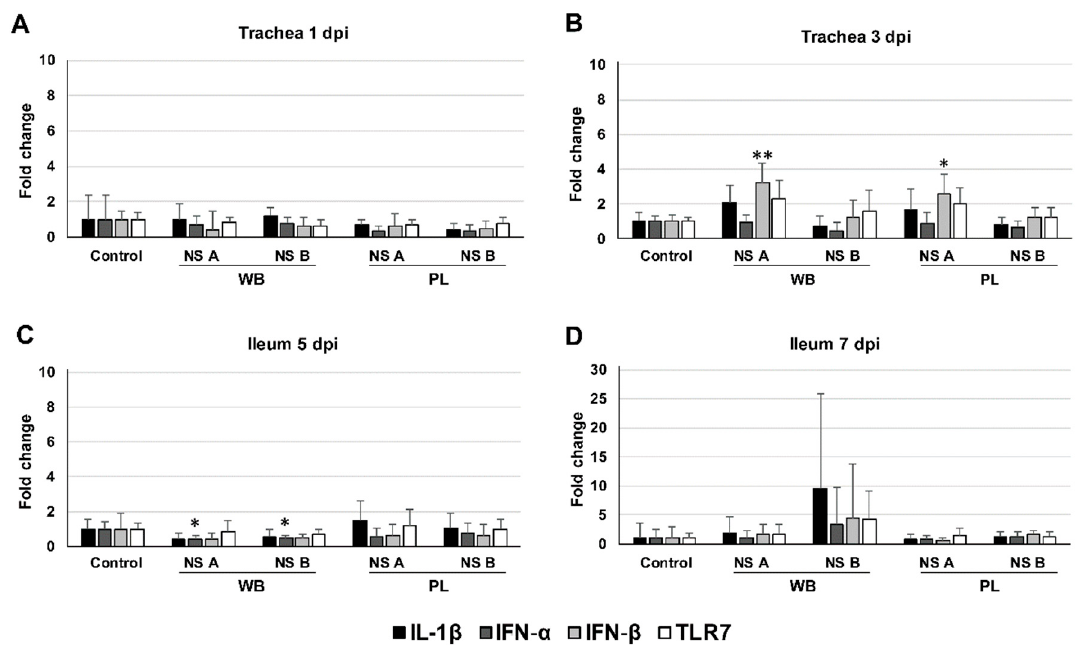
Figure 4. Cytokine mRNA expression in the trachea and ileum. Fold change in IL-1 β , IFN- α , IFN- β , and TLR7 mRNA levels in trachea at ( A ) day 1 and ( B ) day 3, and in ileum at ( C ) day 5 and ( D ) day 7 post inoculation (dpi) of chickens with low pathogenic avian influenza (LPAI) viruses of wild bird-associated H3N8 and H4N6 (WB) and poultry-associated subtypes H8N4 and H9N2 (PL) carrying nonstructural protein (NS) allele A or B. Results of two experimental groups were pooled into a single representative group as follows: H3N8 and H4N6 viruses of NS allele A (WB / NS A), H3N8 and H4N6 viruses of NS allele B (WB / NS B), H8N4 and H9N2 viruses of NS allele A (PL / NS A), and H8N4 and H9N2 viruses of NS allele B (PL / NS B). mRNA expression is shown as the mean fold change relative to the control group ± standard deviation (SD). * p < 0.05, ** p < 0.01.